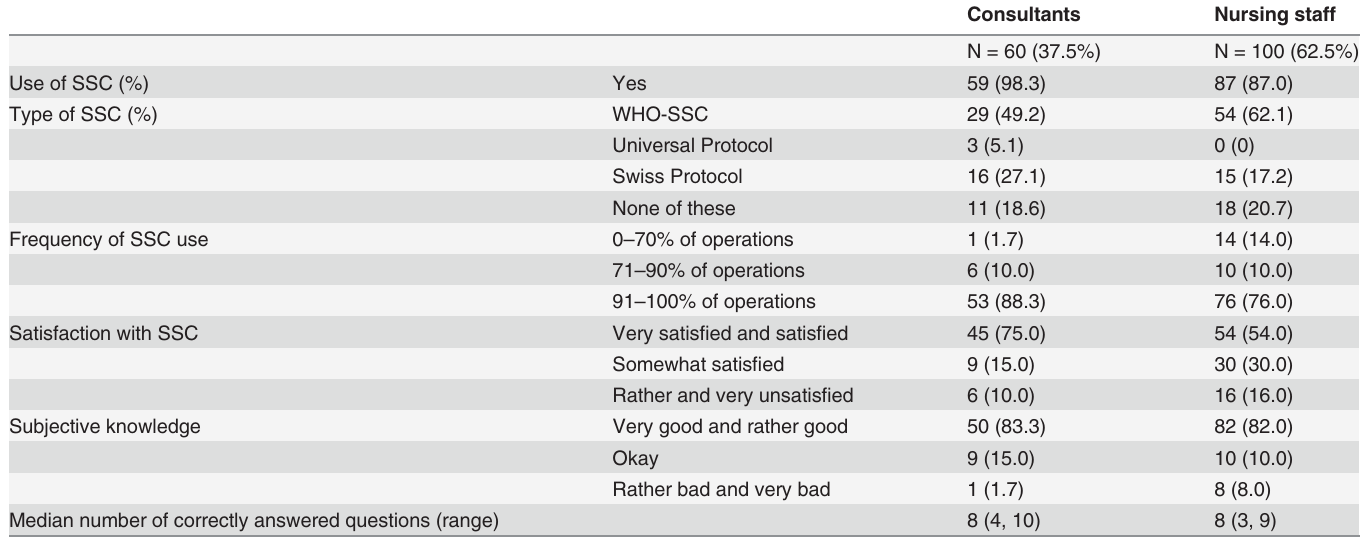
Table 4. Results of the online